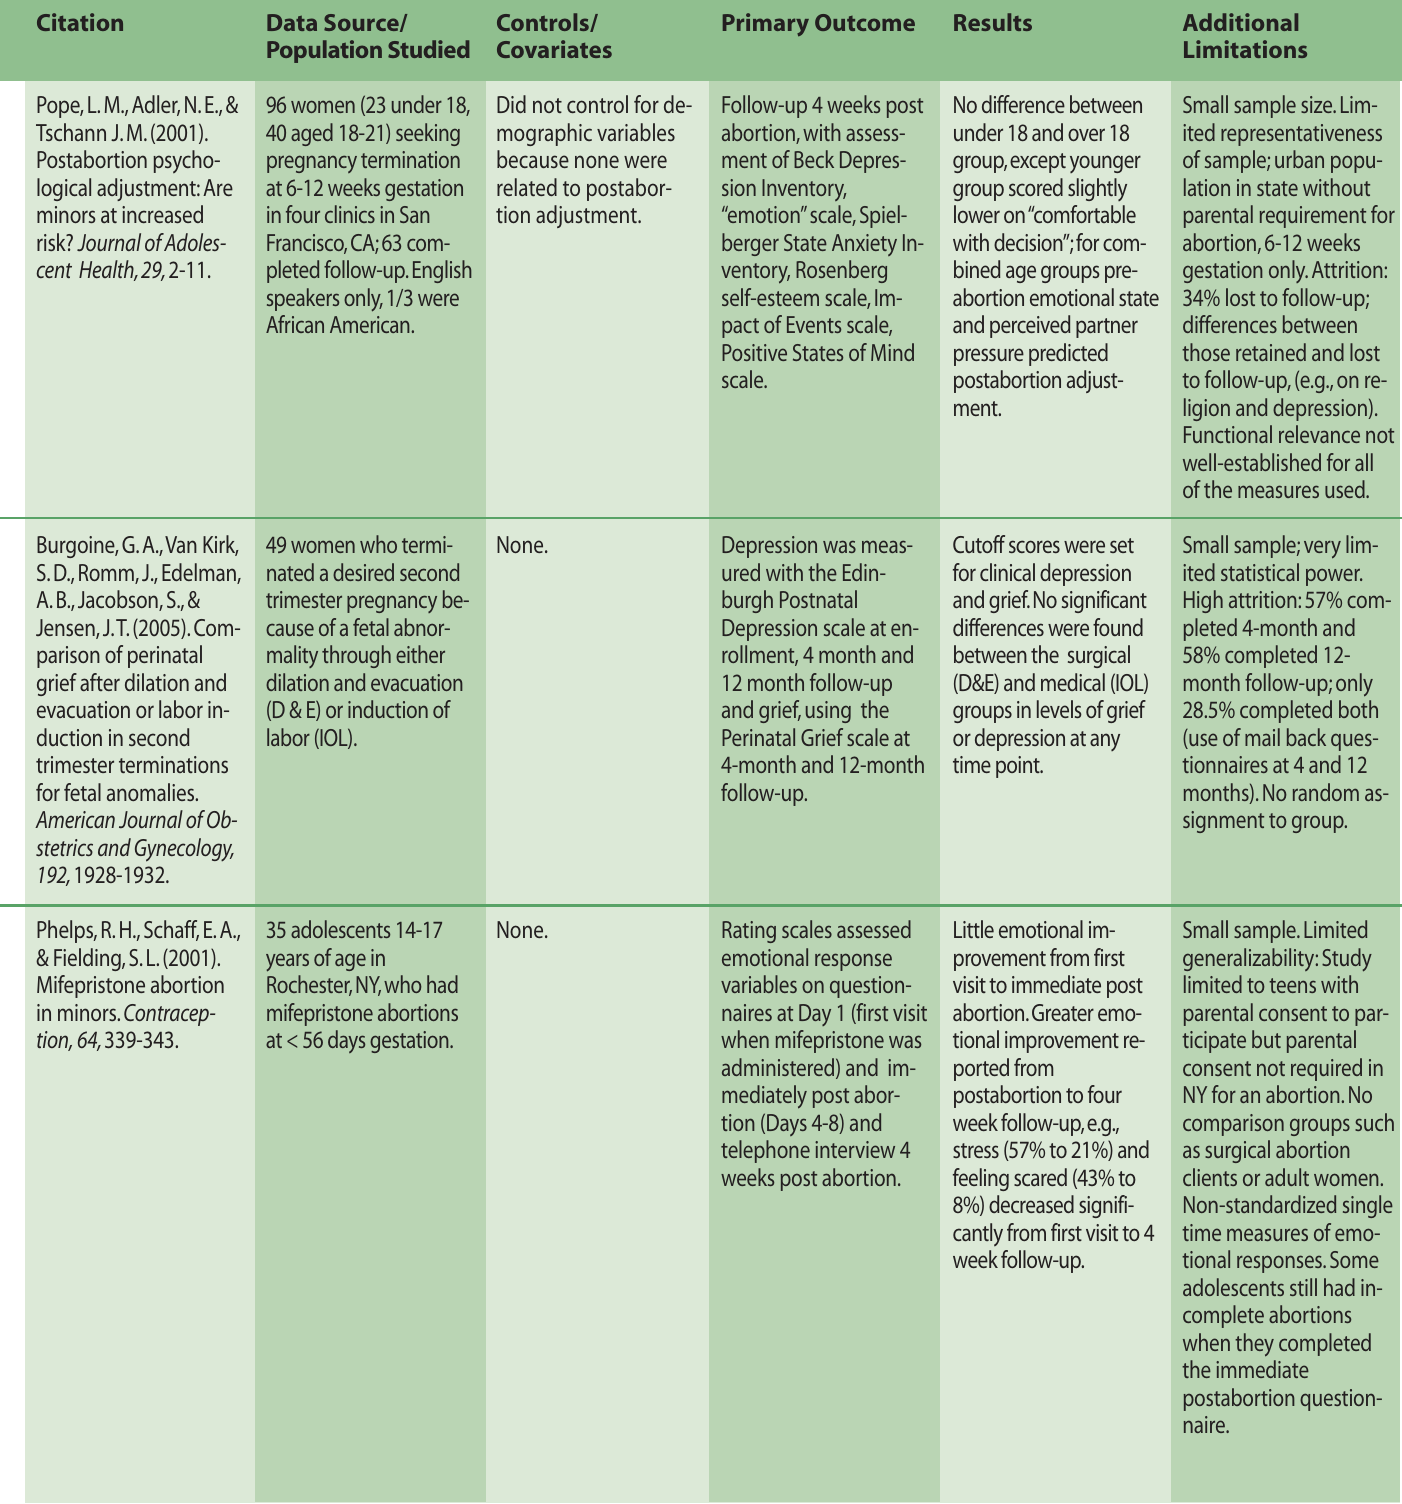
Table 5: U.S.Samples of Abortion Group(s) Only/No Comparison (continued) Other Prospective